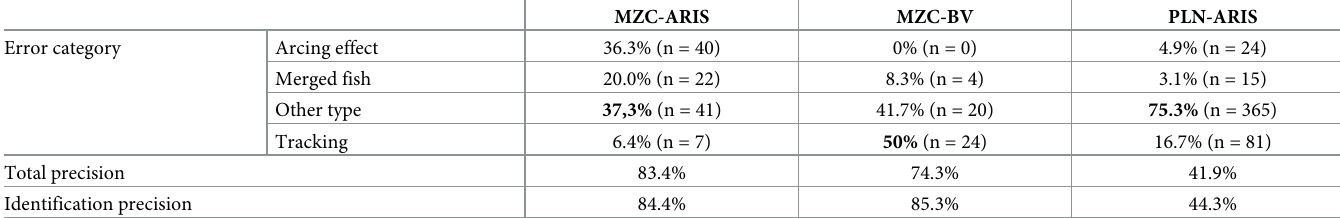
Table 5. Percentage of false positives (FP) in each error category observed, total precision and identification precision (i.e. excluding tracking errors) for each data- set: Mauzac site/ARIS camera (MZC-ARIS), Mauzac site/BlueView camera (MZC-BV) and Port-La-Nouvelle site/ARIS camera (PLN-ARIS). Bold text indicates the largest percentage per